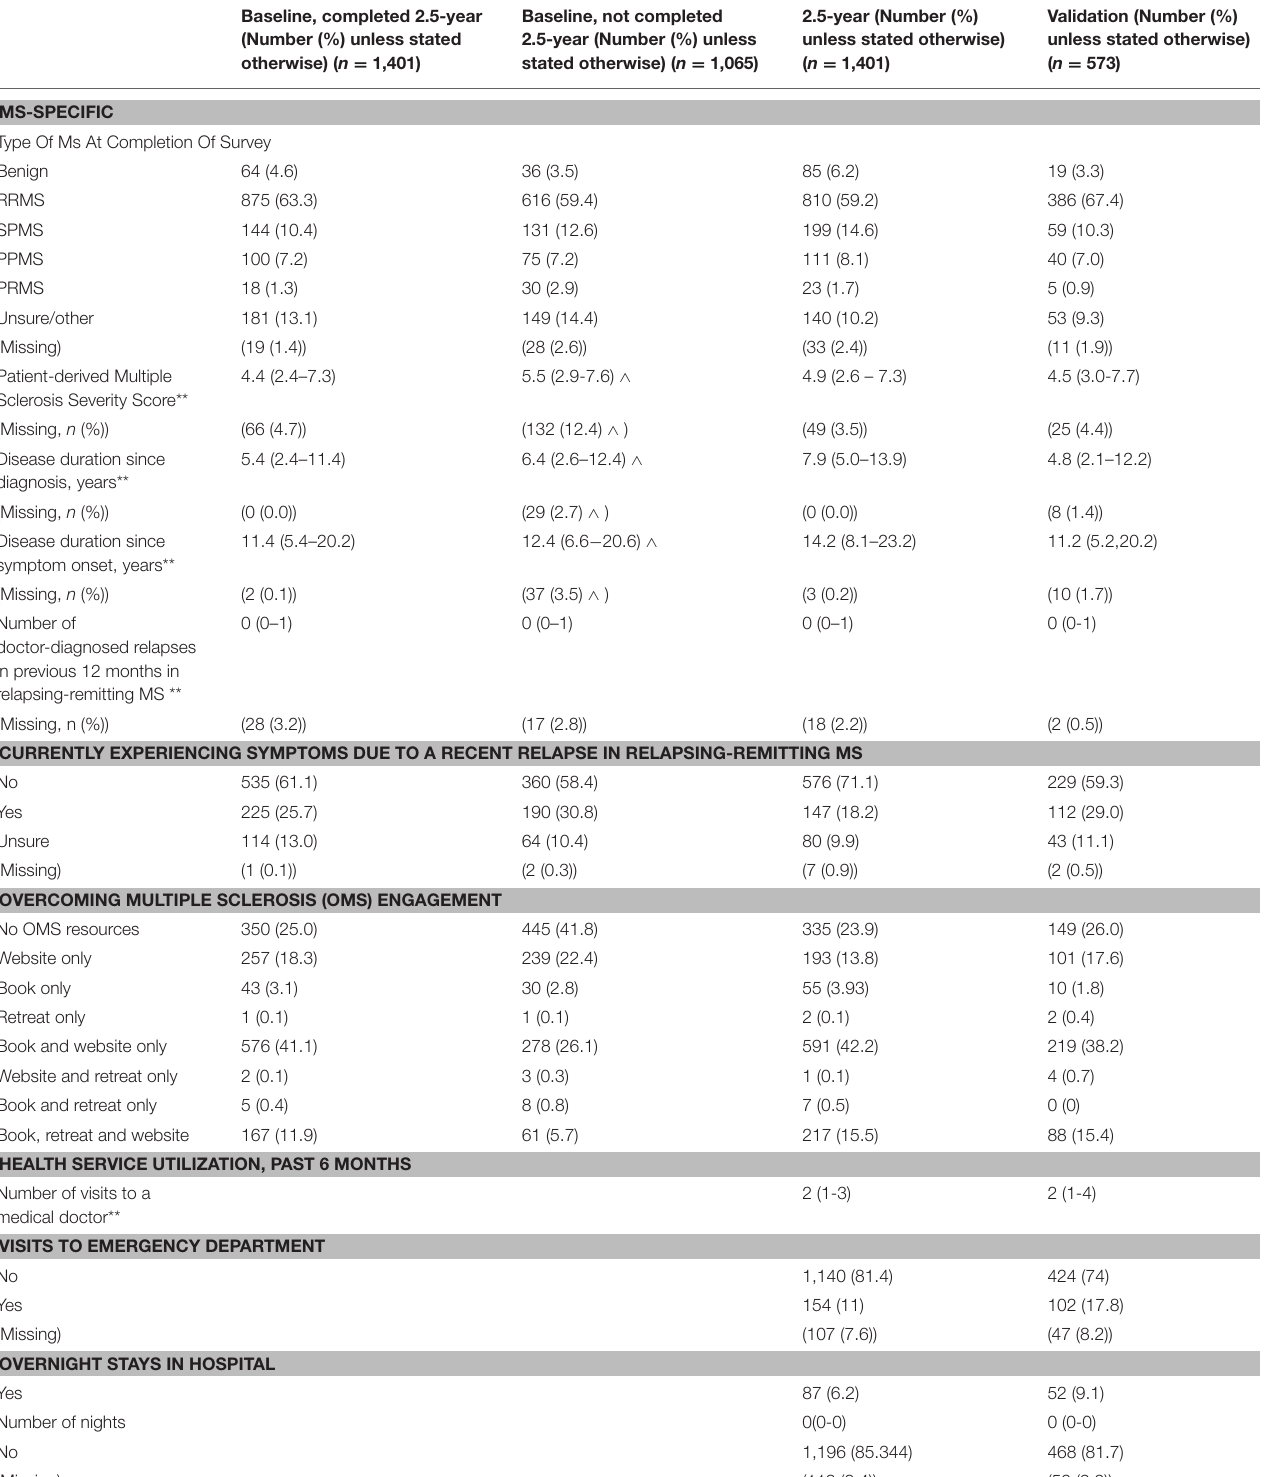
TABLE 3 | MS-Specific characteristics of the 2.5-year and validation cohorts and the baseline characteristics of the participants who completed and were lost to follow-up at 2.5-year follow-up. Baseline, completed 2.5-year (Number (%) unless